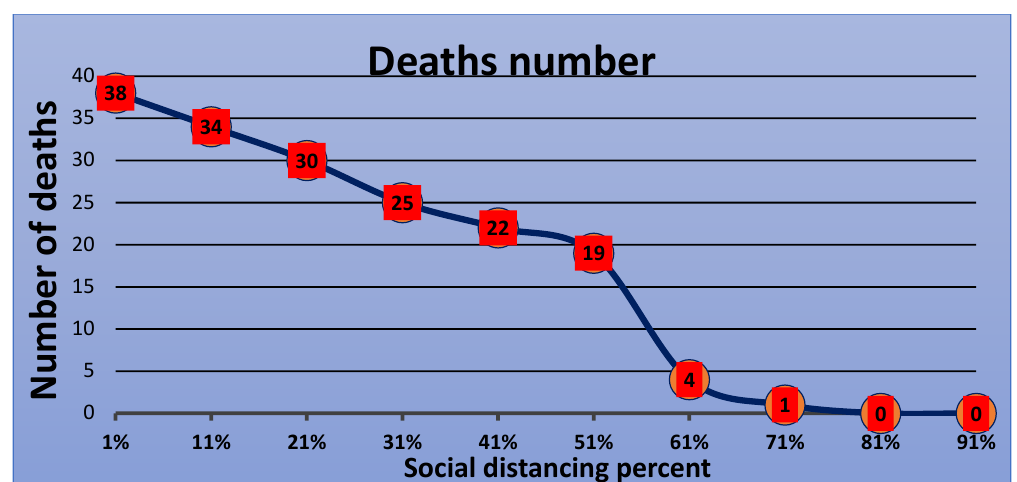
Figure 17. Effect of social distancing on infection rates.